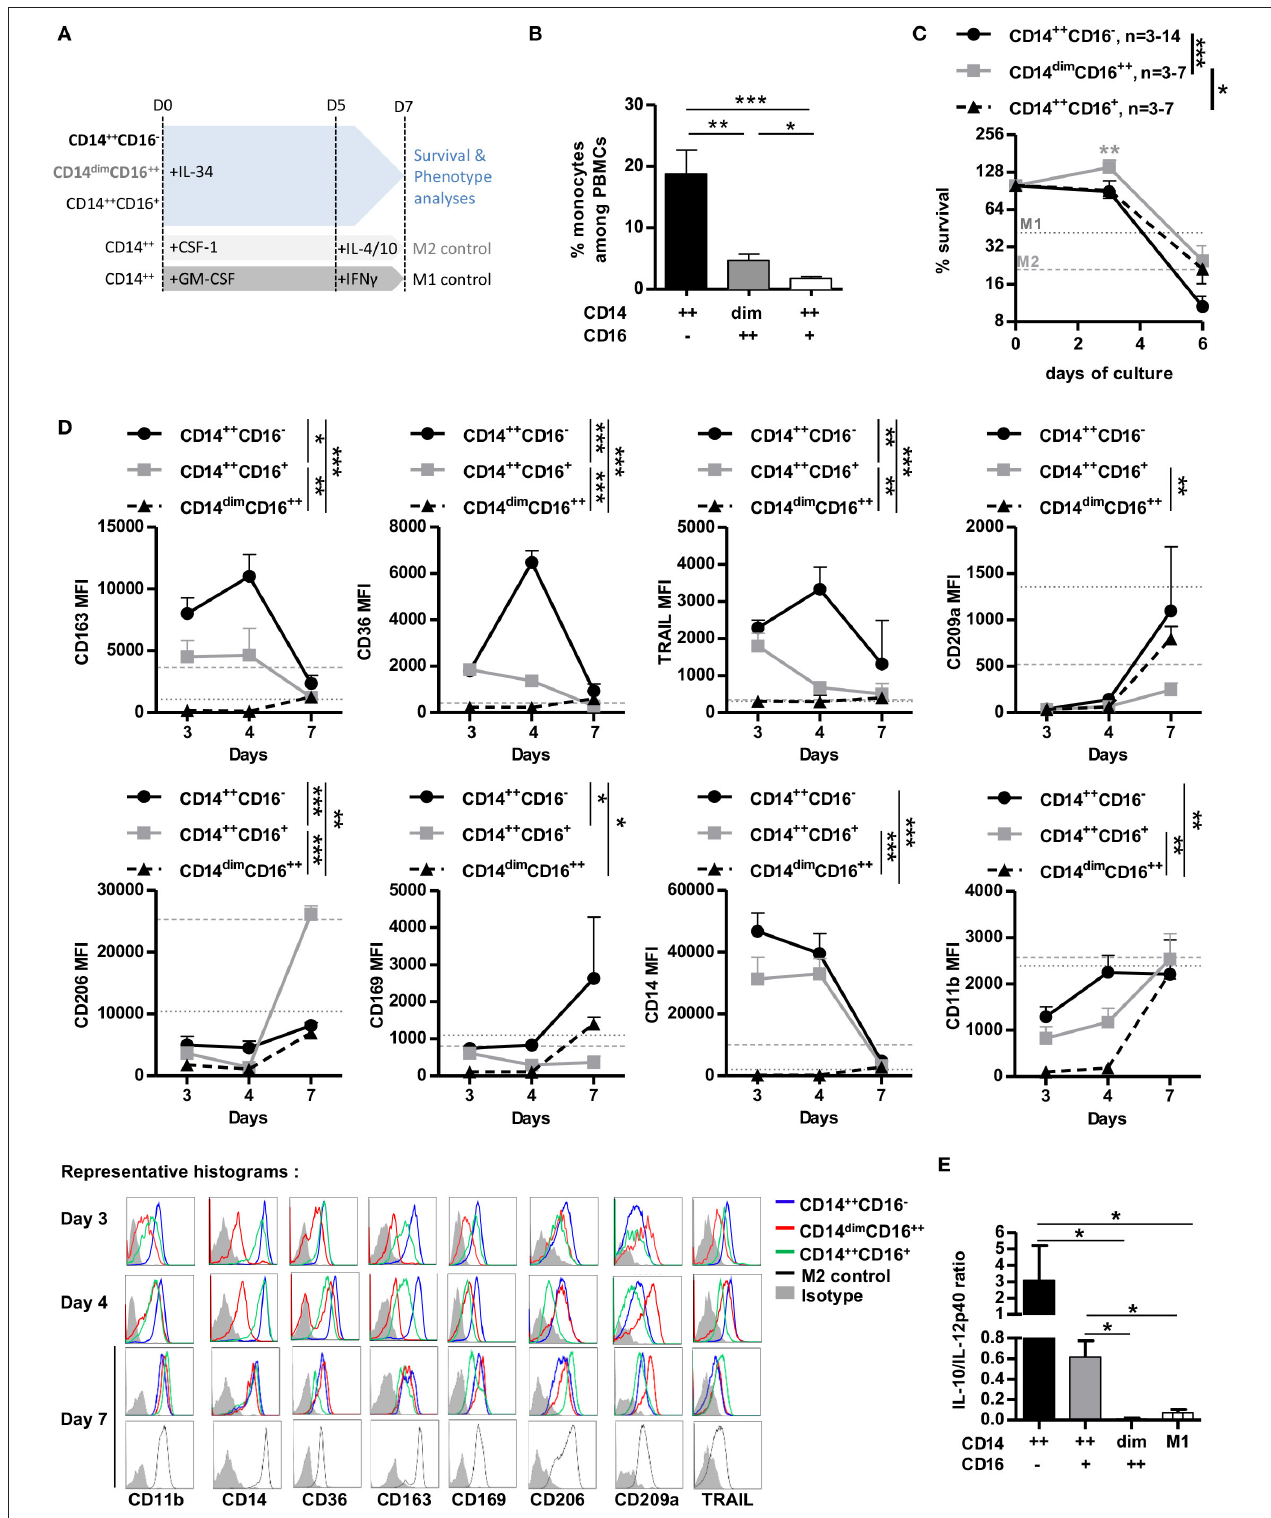
FIGURE 2 | CD14 ++ monocytes are the main mediators of IL-34-induced immunoregulation. (A) Schematic depicting conditions and timing of supplementation in cytokines in monocyte cultures. LPS was added for the last 24h for cytokine release analysis only. (B) Frequency of monocyte subsets in PBMCs of healthy